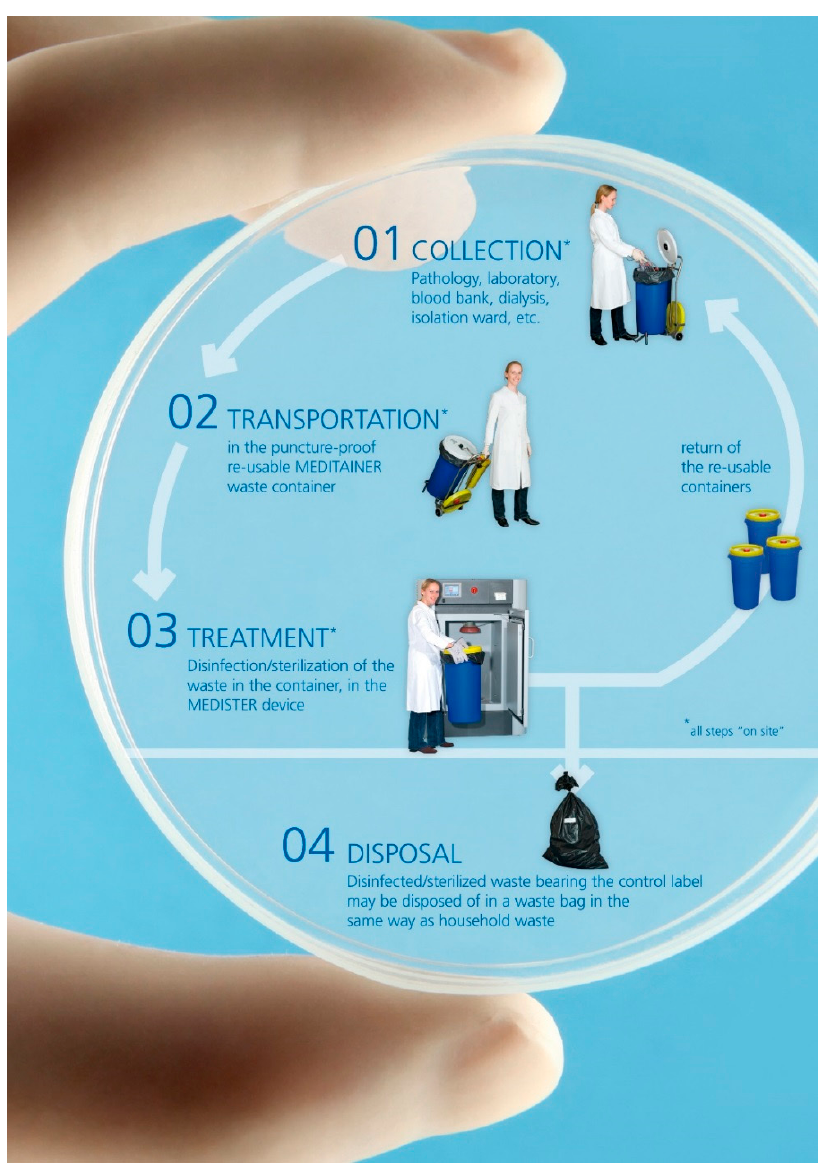
Figure 1. Example for closed waste disinfection system.